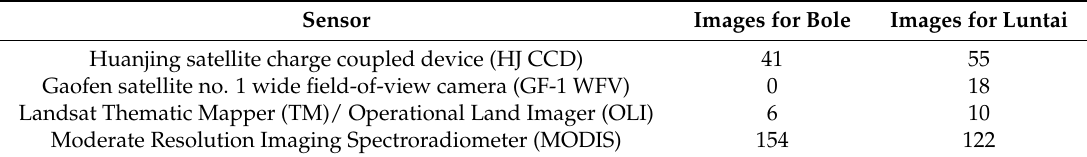
Table 1. The number of the four kinds of satellite data used in Bole and Luntai. Sensor Images for Bole Images for Luntai Huanjing satellite charge coupled device (HJ CCD) 41